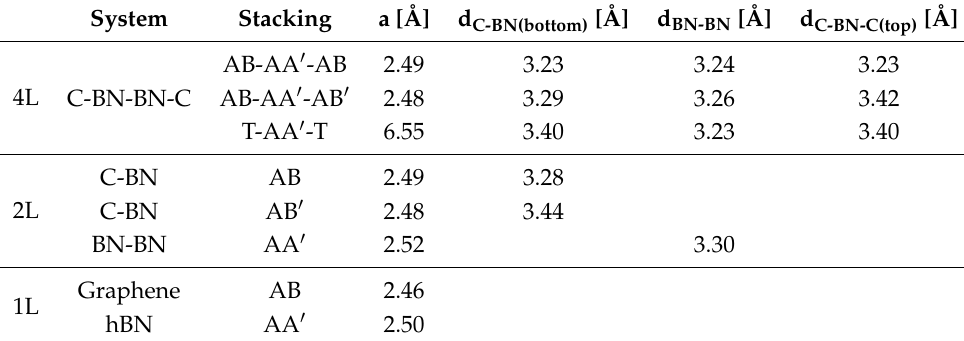
Table 2. Lattice parameters and distances between the layers in the systems studied. The lattice √ 7 HT (a = 6.55 Å) corresponds to an effective 1 constant of the twisted √ 7 × about 2.47 Å. Calculations are done using PBE-vdW b86r